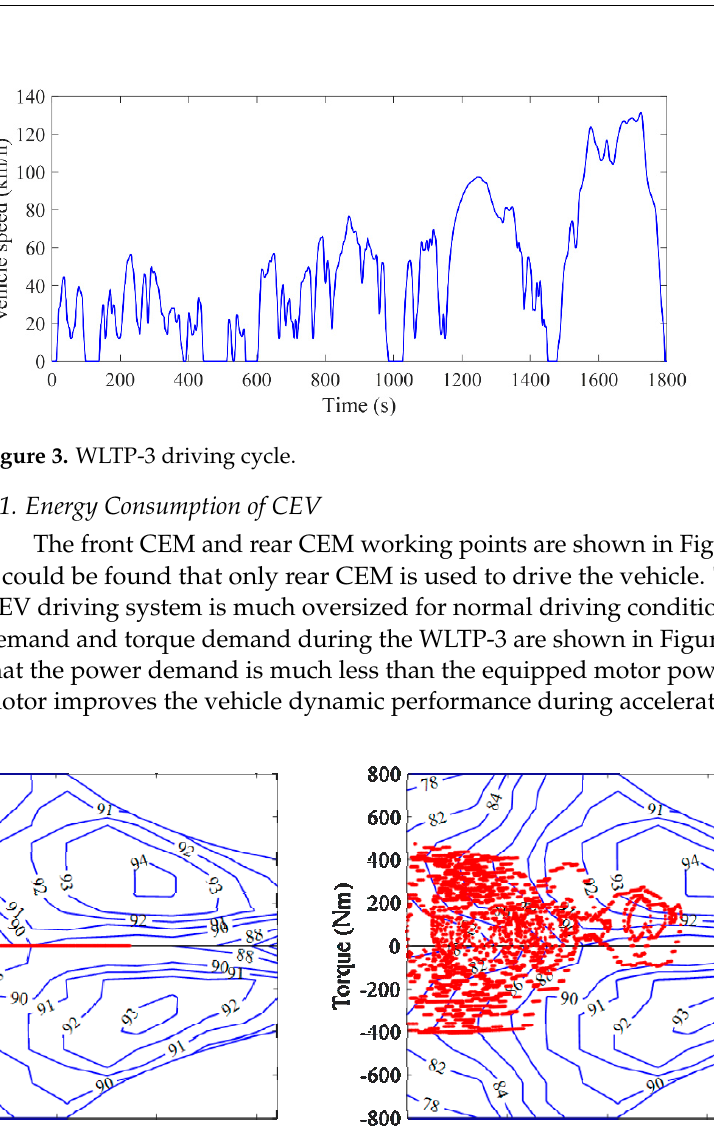
Figure 3. WLTP-3 driving cycle. Table 1 . Parameters of the CEV.